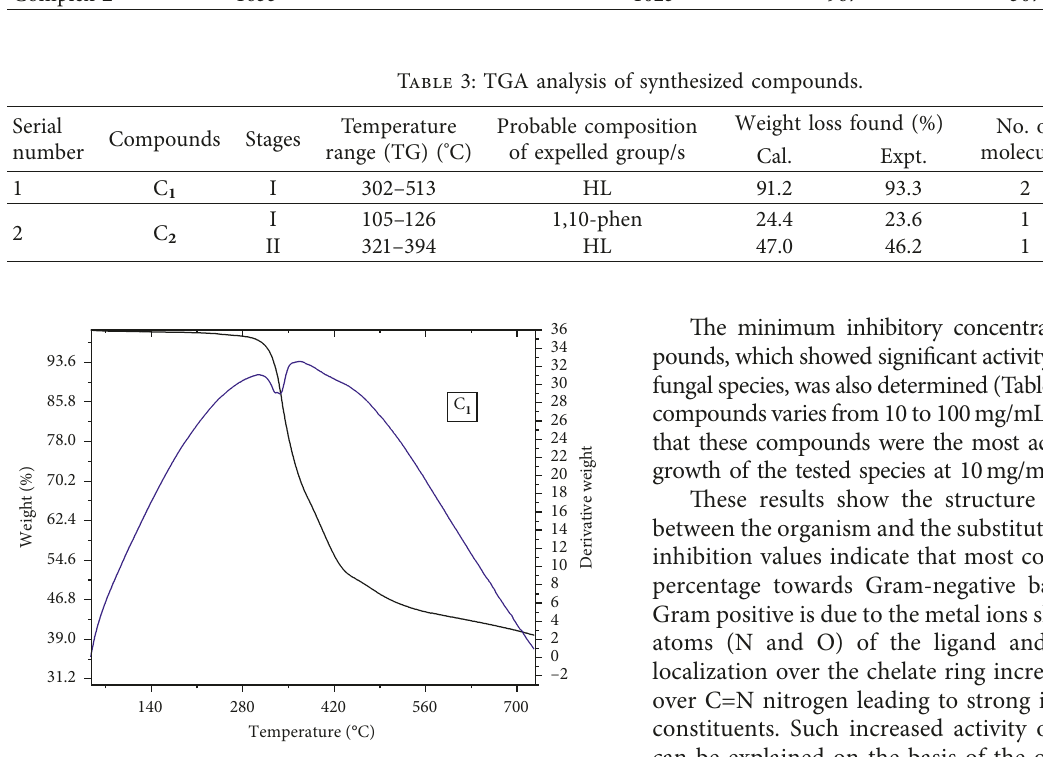
Figure 1: TGA-DTA thermogram of complex 1 .